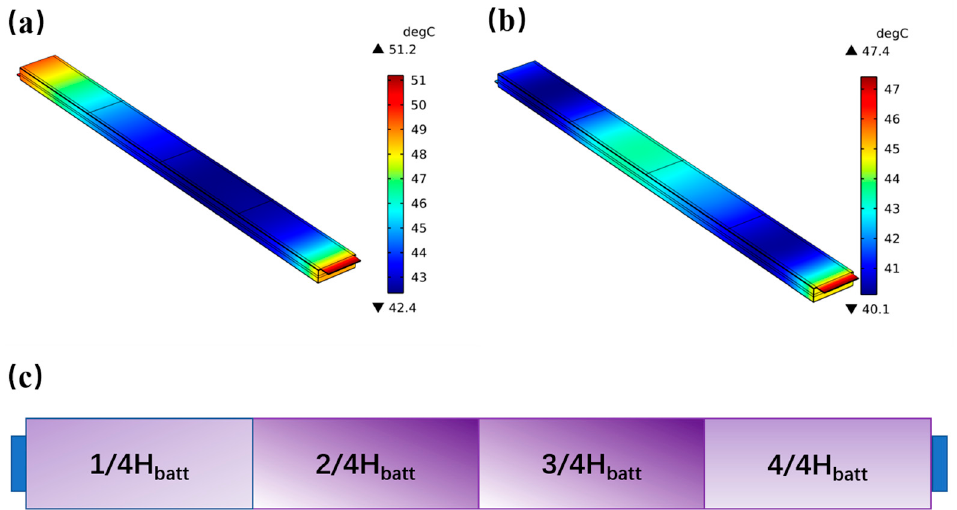
Figure 12. Effect of improving the heat exchange on the pole-ear side on the three-dimensional temperature distribution. ( a ) Temperature distribution of the original scheme; ( b ) Temperature distribution of the added pole-ear side heat transfer; ( c ) graphical representation of the improved heat transfer.